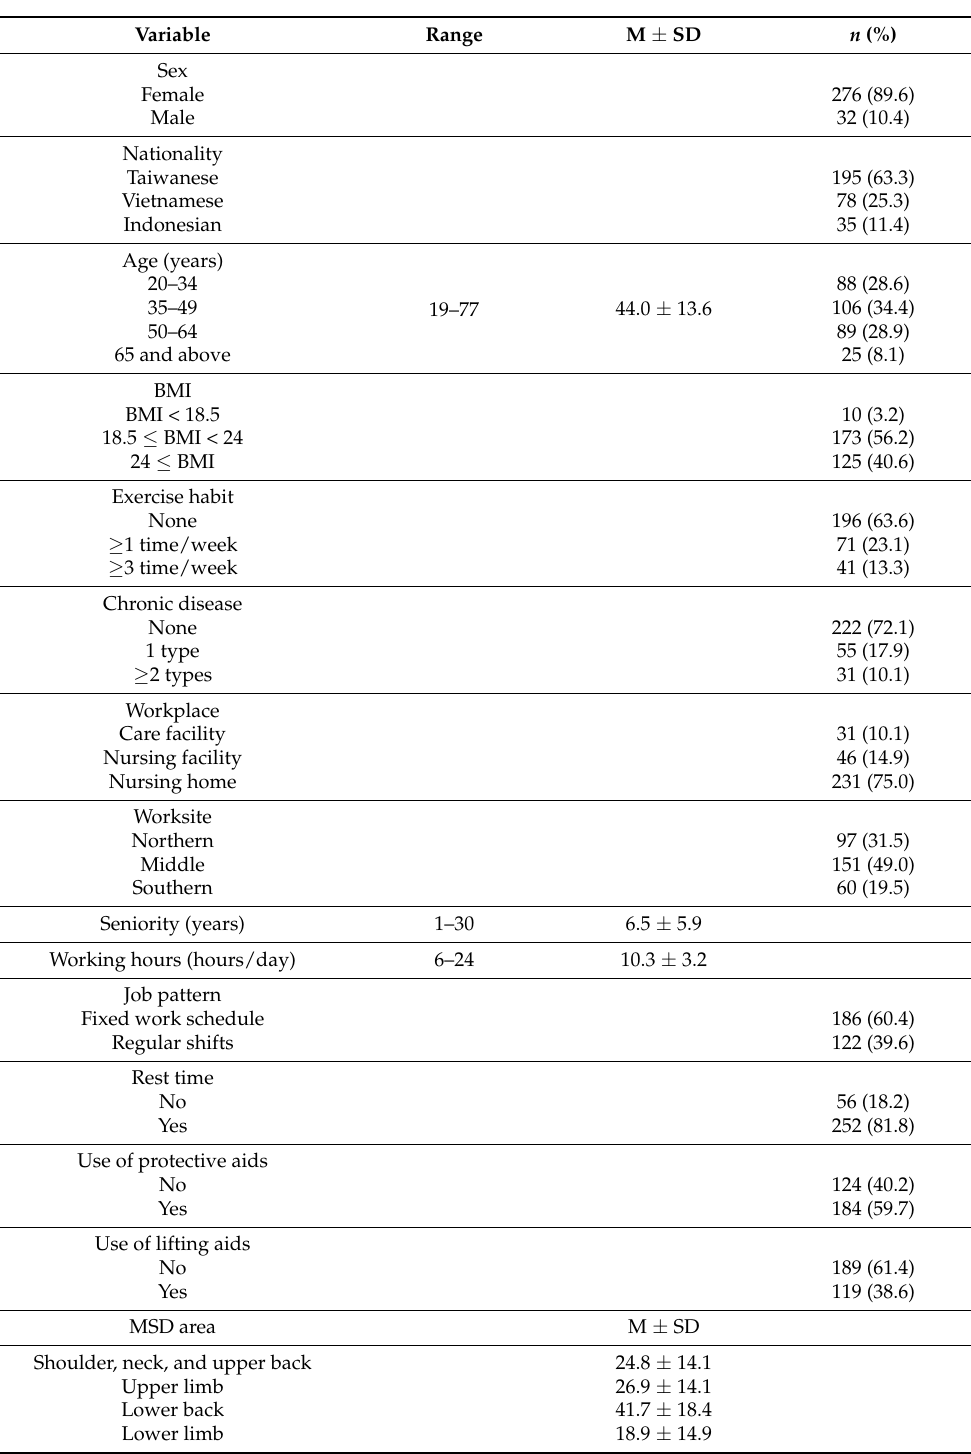
Table 1. Analysis of the demographic characteristics, job background, and MSDs among nursing aides in LTCFs ( n =